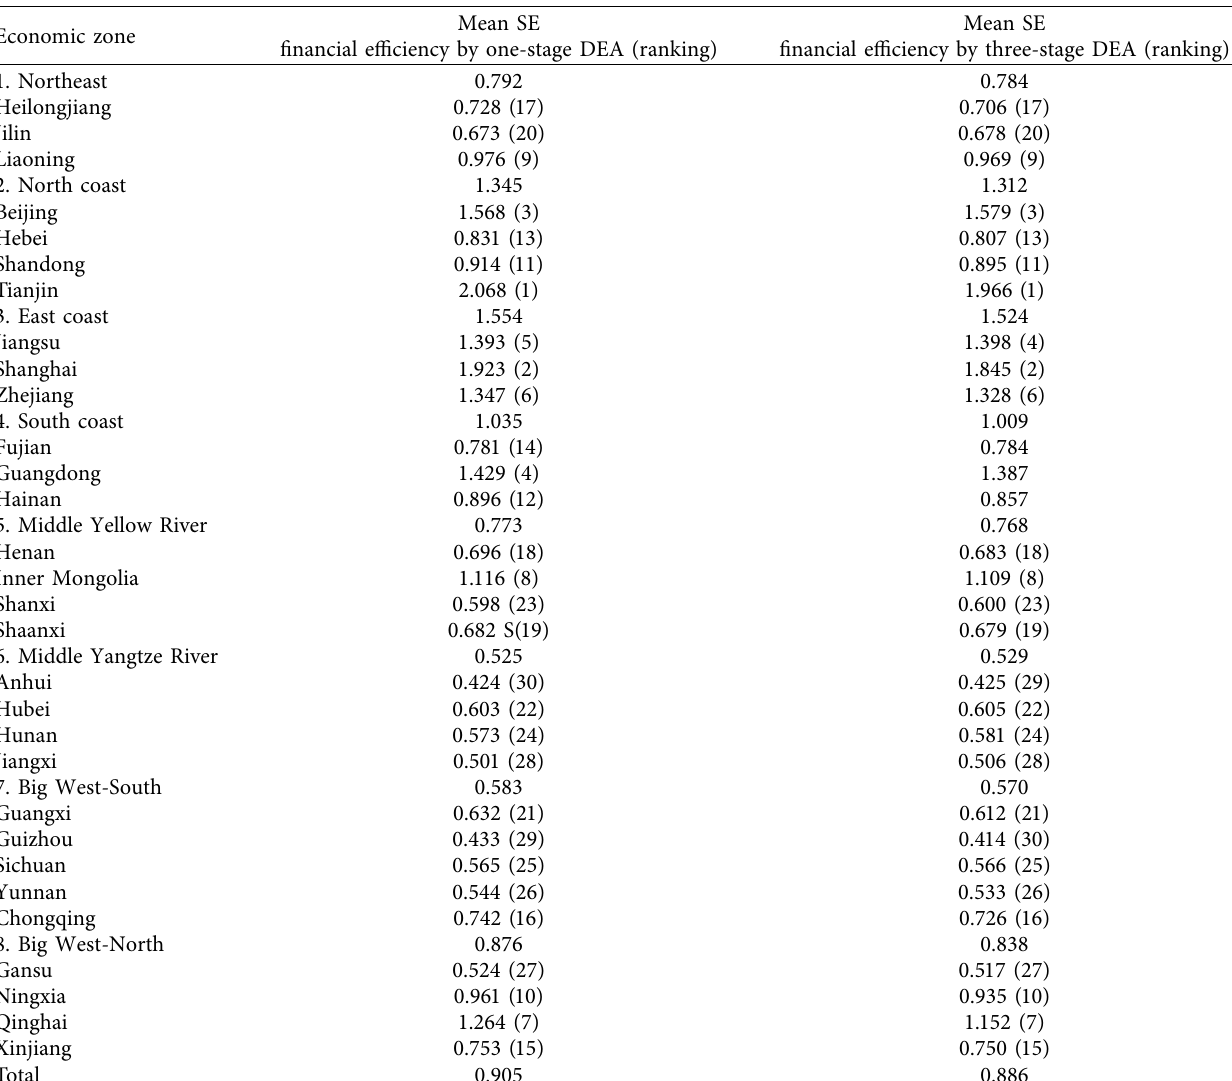
Table 4: Statistical descriptions of the regional financial efficiencies in the eight economic zones covering the period from 2004 to 2016.